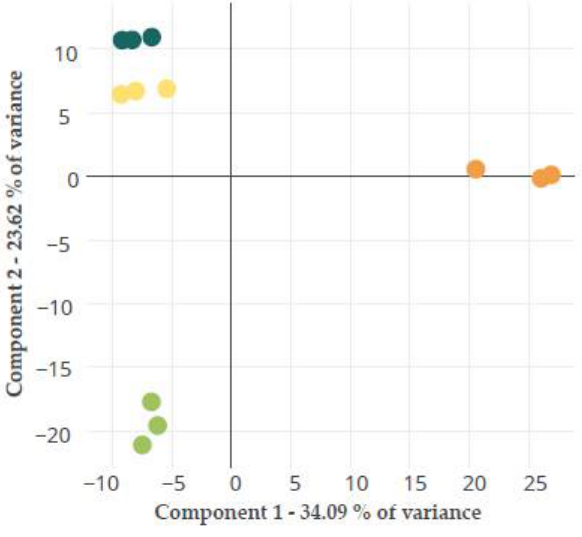
Figure 1. PCA analysis of the variable features dataset identified in Q. ilex leaf seedlings during both treatments (irrigated and non-irrigated seedlings) and both sampling times (days 17 and 24). From the m / z of the ion precursor and derived fragments, 342 compounds were annotated (Table 2 and Table S1), with redundancy for some of them. They belonged to different chemical families (Table 2), with 22 having three or more identified compounds. The secondary metabolism group, and concretely, that of phenolic compounds, at the number of 131, was the most represented. Out of 342 annotated compounds, 28 were included in very heterogeneous classes (Table 2 and Table S1). These data show, as previously observed in Q. ilex acorns [25], the complexity and richness of the Q. ilex secondary metabolites. Table 2. Total number of annotated compounds classified by chemical families. Chemical Family